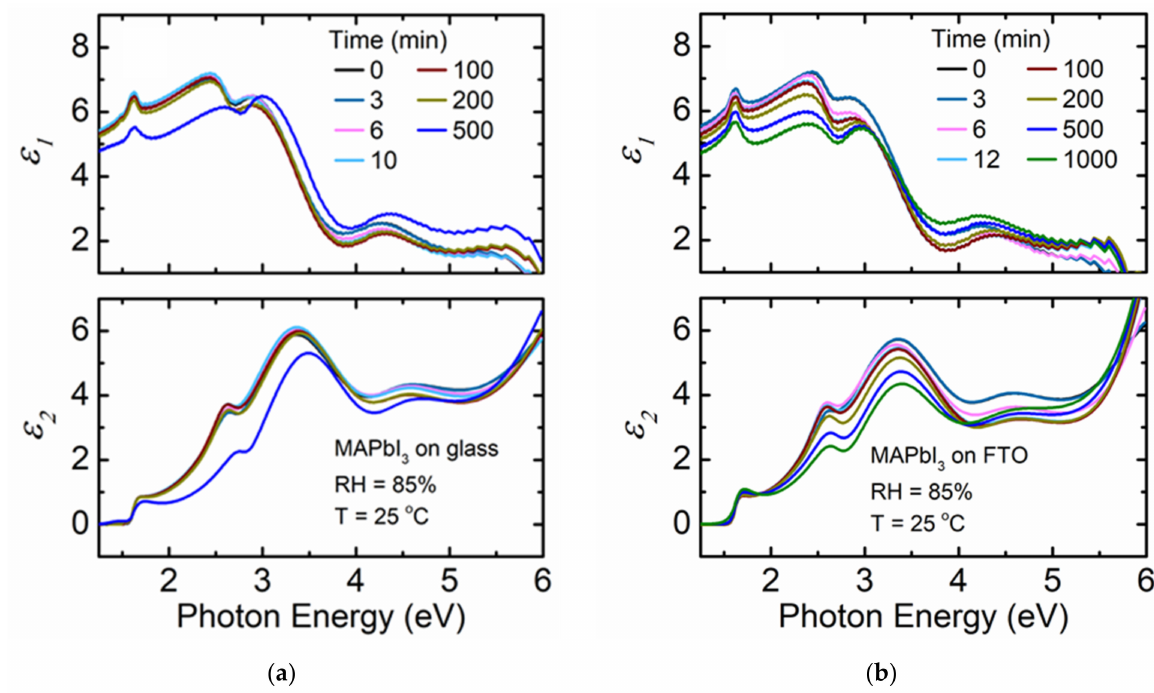
Figure 2. Complex dielectric function ( ε = ε 1 + i ε 2 ) spectra at selected time points for thin film MAPbI 3 deposited on ( a ) soda lime glass and ( b ) fluorine-doped tin oxide (FTO) coated glass when exposed to 85% relative humidity (RH) at 25 ◦ C. RH is introduced at 5 and 4 min for ( a ) and ( b ),